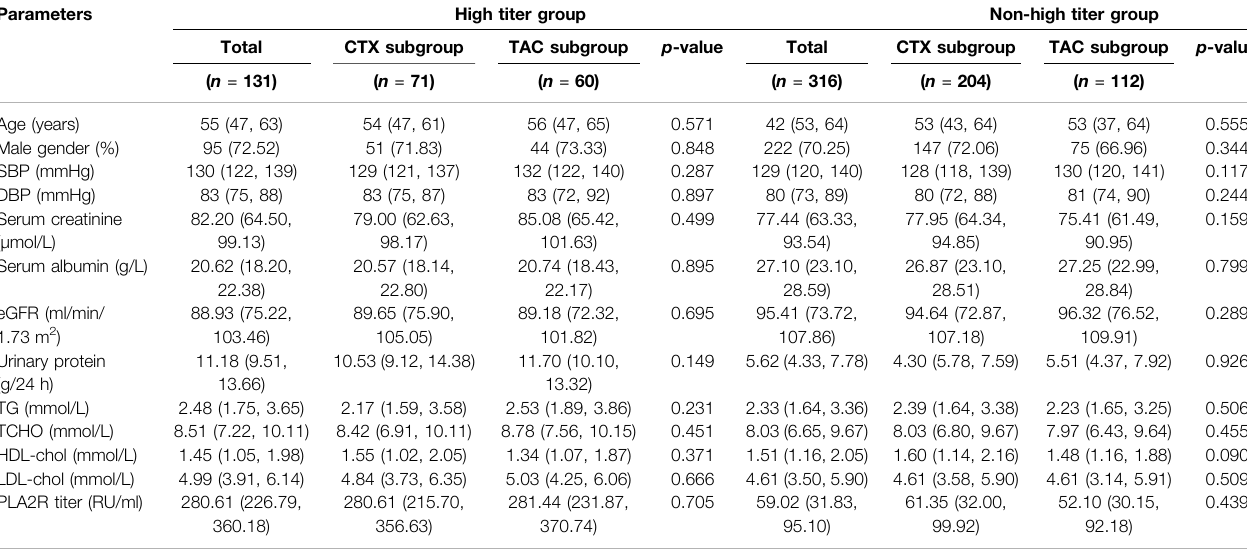
TABLE 4 | Comparison of baseline clinical characteristics between CTX subgroup and TAC subgroup in the two titer groups. Parameters High titer group Non-high titer